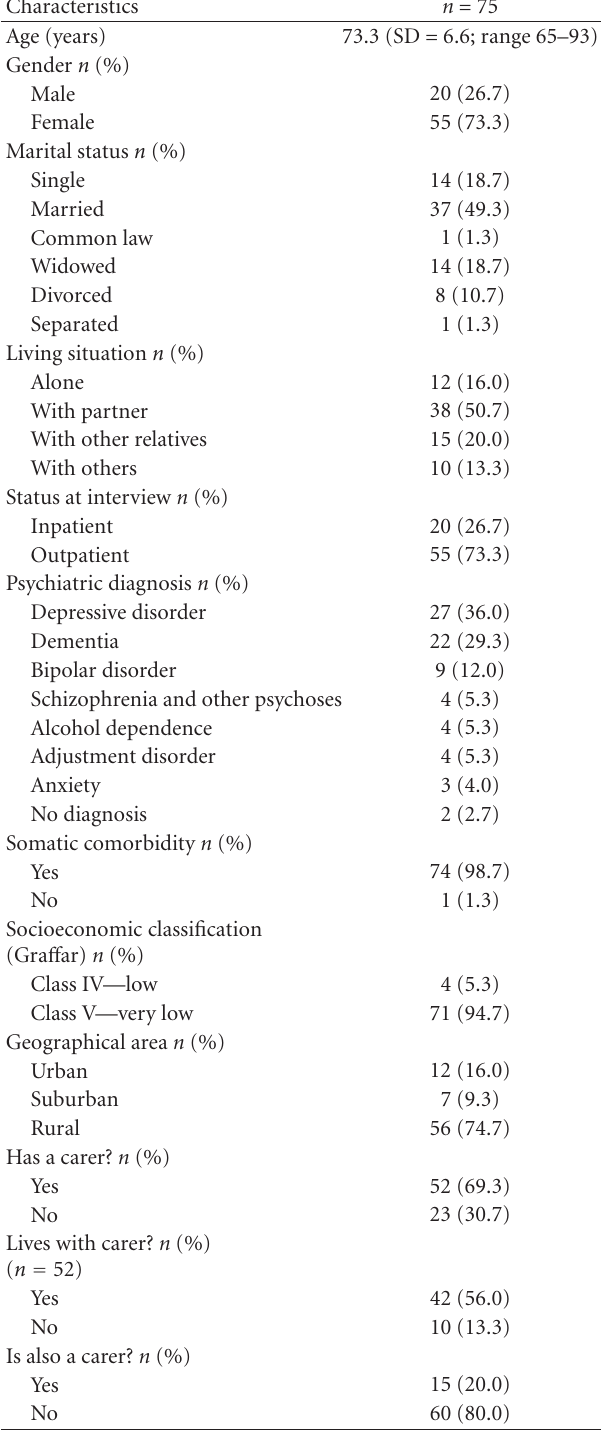
Table 1: Sociodemographic and clinical characteristics of subjects. Characteristics